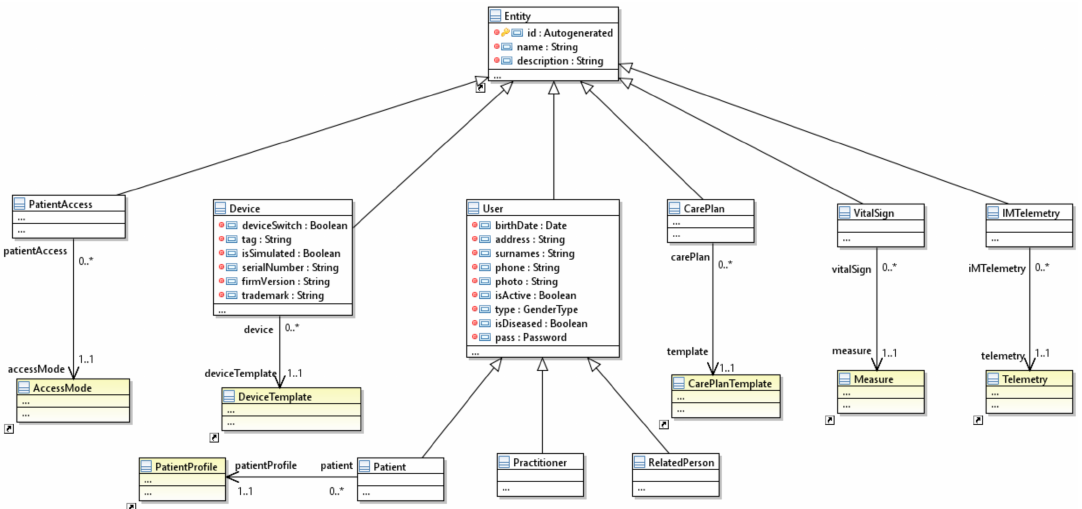
Figure 8. The entity hierarchy metamodel of the MoSIoT scenario